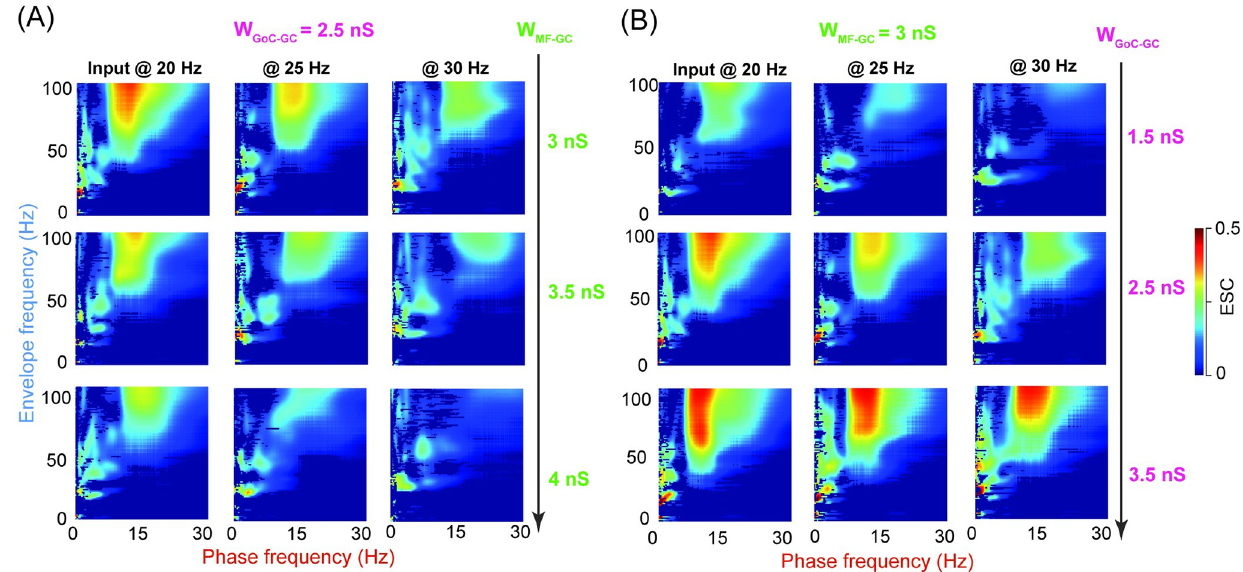
Fig 6. Phase-amplitude coupling of GCs reinforced by GoC inhibition. (A) The ESC measure as a function of frequencies of phase (low-pass filer) and envelope (high-pass filter) computed for GC oscillations with Poisson inputs at 20, 25, and 30 Hz in FFI+FBI networks. The change of the ESC over increasing W MF − GC excitation with fixed W GoC − GC inhibition. (B) Similar to (A), but for increasing W GoC − GC inhibition with fixed W MF − GC excitation.